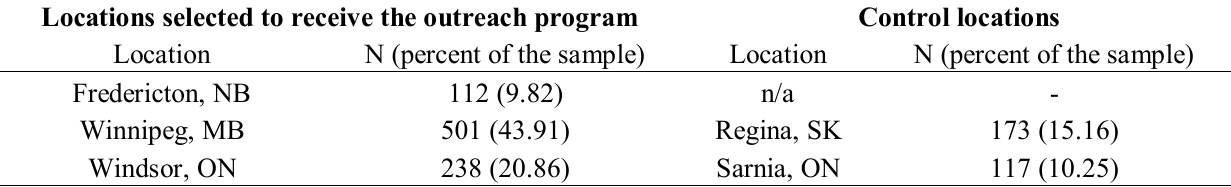
Table 1. Study locations and sample sizes. N = 1141.